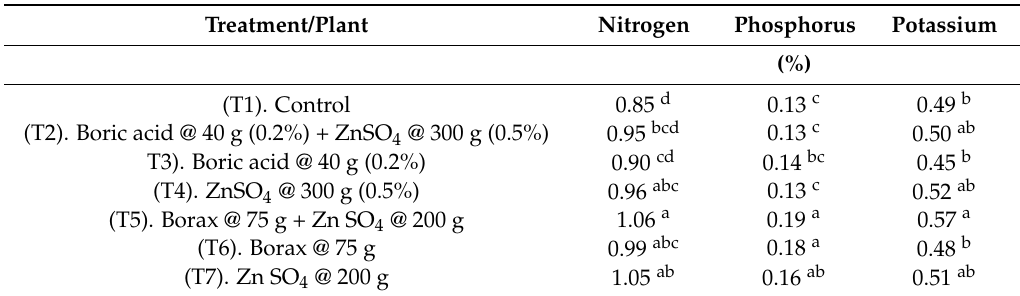
Table 4. Mean N, P, and K mineral contents in mango leaves (cv. Chaunsa white) sampled at the end of each crop year in July (2013–2015)